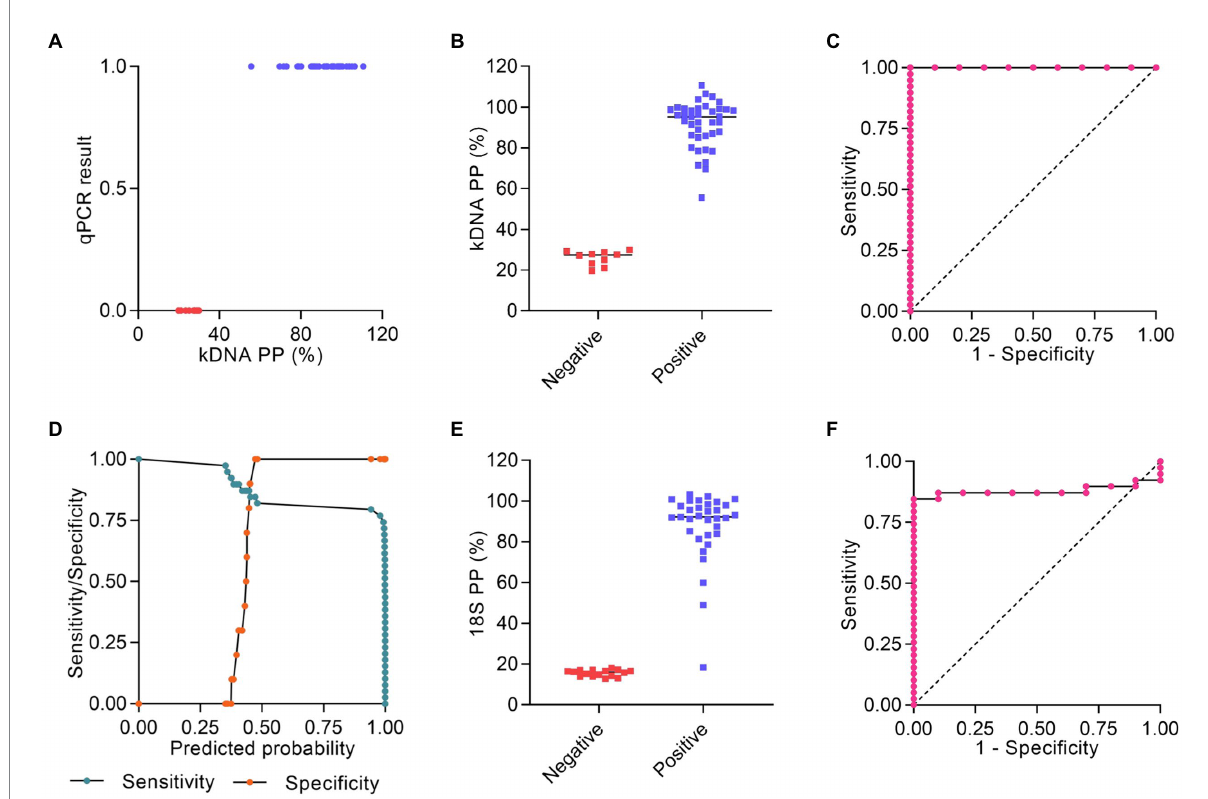
FIGURE 7 Statistical analysis of Cas12a assay results. (A–C) Raw fluorescence data of the Cas12a detection assay on the kDNA target using DNA from clinical samples were expressed as percentage positivity (PP) relative to a positive control, which was run in each plate. (A) The predictor variable (PP) predicts the outcome variable Y (qPCR result) perfectly since PP > 29.9% corresponds to Y = 1 (positive) and PP ≤ 29.9% corresponds to Y = 0 (negative). (B) Plot representing the PP of positive ( n = 39) and negative ( n = 10) results obtained by the kDNA PCR/CRISPR assay in clinical samples. (C) ROC curve for the kDNA PCR/CRISPR test, ratio of true positive rate (sensitivity) vs. false positive rate (1-specificity) with area under the ROC curve of 1. (D–F) Raw fluorescence data of the Cas12a detection assay on the 18S rDNA target gene using DNA from clinical samples were expressed as PP relative to a positive control, which was run in each plate. (D) Sensitivity/specificity analysis vs. predicted probability (i.e., probability cutoff). The probability cutoff point determines the sensitivity (85%) and specificity (100%) of the 18S PCR/CRISPR assay. (E) Plot representing the PP (cutoff: 18.251%) of positive ( n = 33) and negative ( n = 16) results obtained by the 18S PCR/CRISPR assay in clinical samples. (F) ROC curve for the 18S PCR/CRISPR test, ratio of true positive rate (sensitivity) vs. false positive rate (1-specificity) with area under the ROC curve of